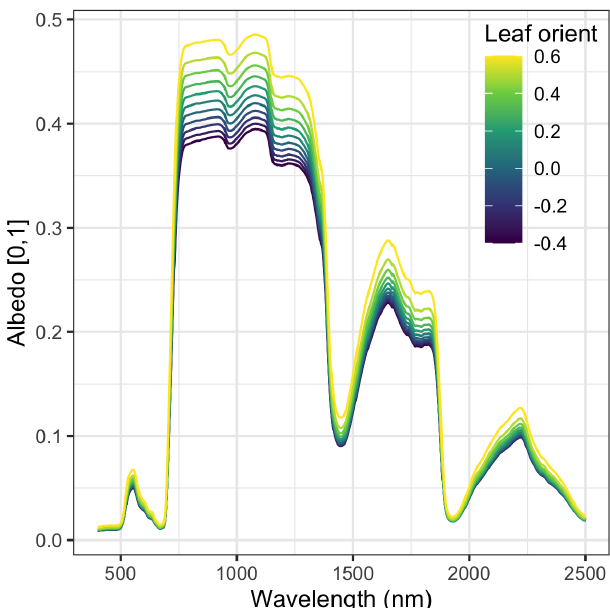
Figure A3. Same as above but instead varying leaf orientation factor ( χ ).